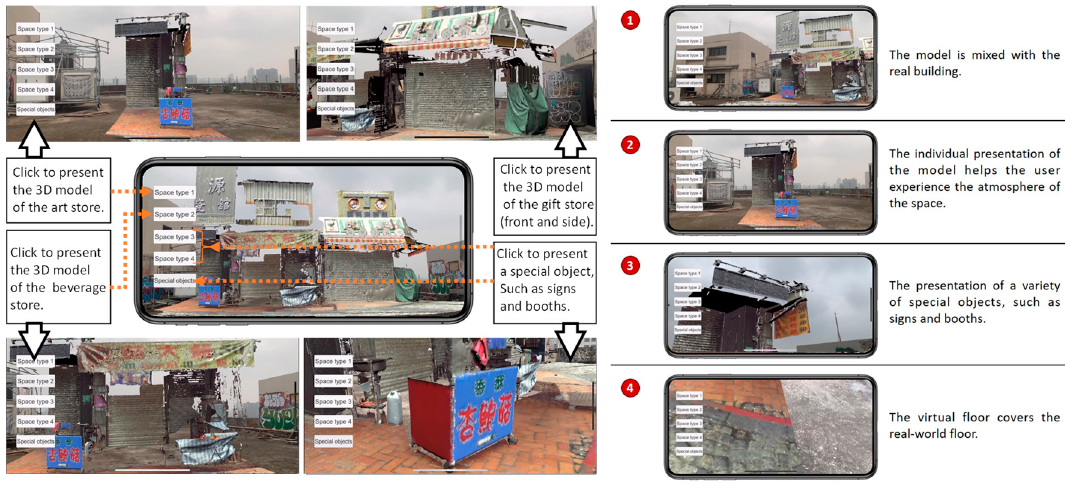
Figure 7. System interface for Yingge.